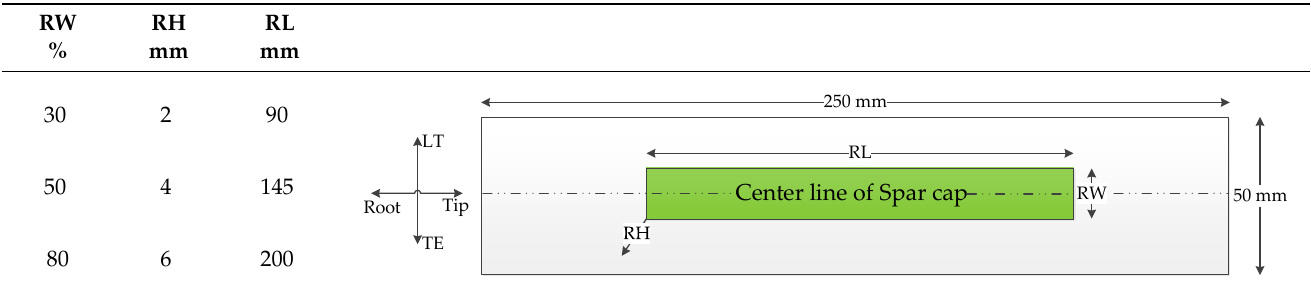
Table 1. Structural repair analysis